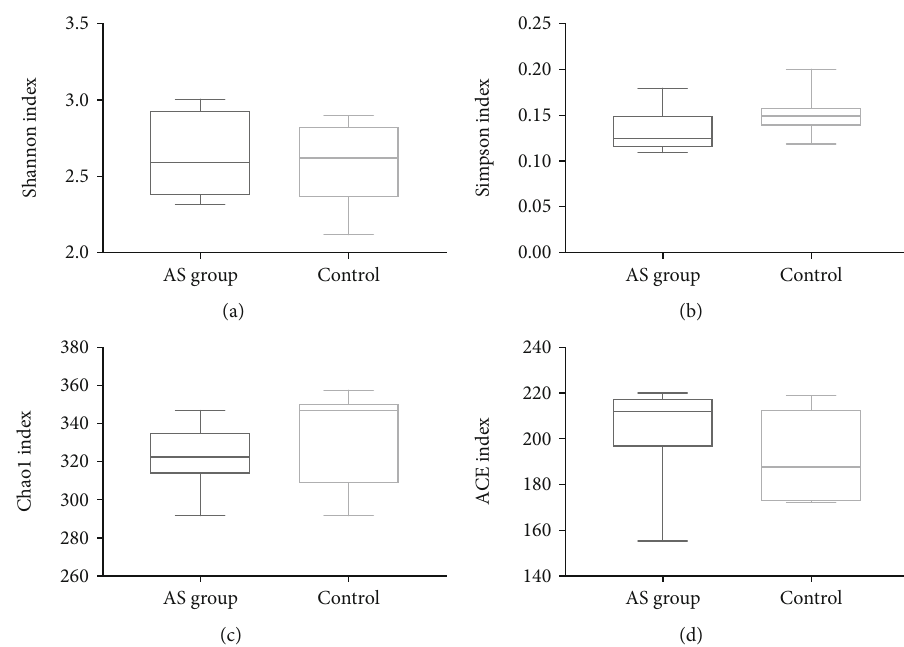
Figure 2: The diversity indices associated with populations of bacteria present in feces. Box plots re fl ect microbiome diversity discrepancies between the AS cases and HCs as revealed by the Shannon index (a), Simpson index (b), Chao1 index (c), and ACE index